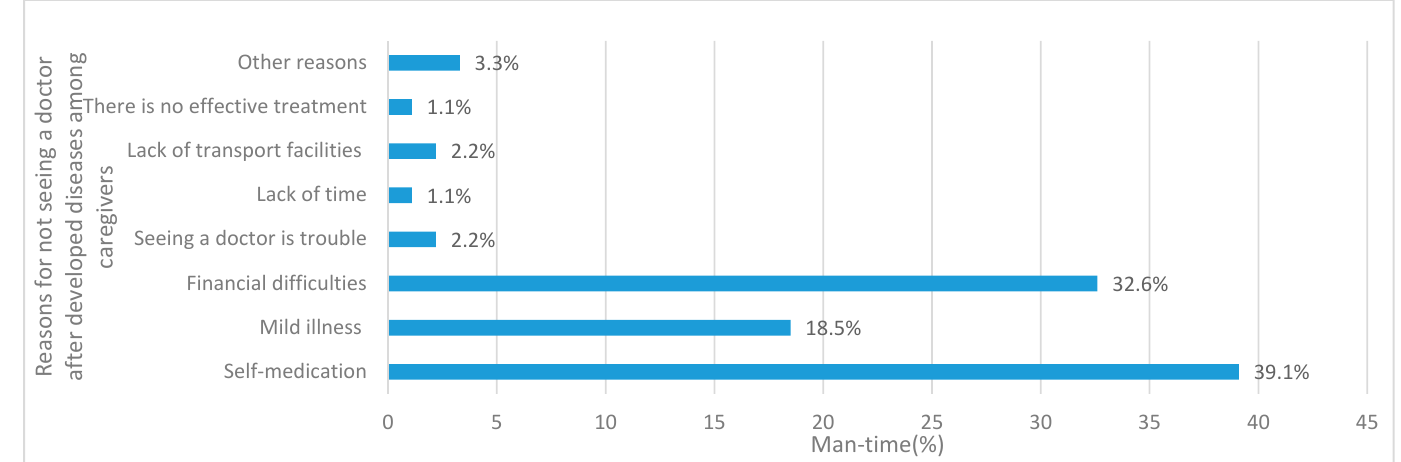
Figure 1. Reasons for not seeing a doctor after developing diseases among caregivers in the past two weeks.